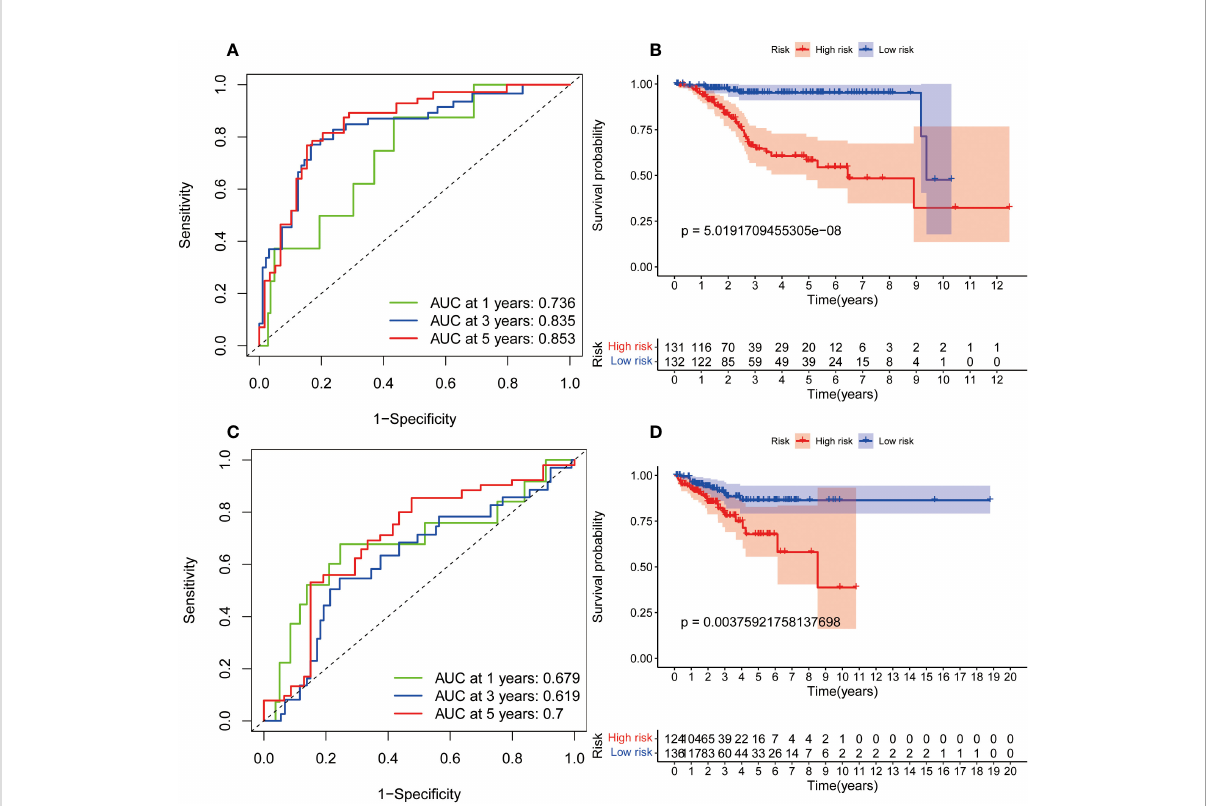
FIGURE 5 The internal veri fi cation of the predictive signature for OS relied on TCGA-UCEC data. (A) The ROC curve at 1-, 3-, and 5-year survival based on internal training cohort. (B) Kaplan-Meier survival curve in internal training cohort. (C) The ROC curve at 1-, 3-, and 5-year survival based on internal validation cohort. (D) Kaplan-Meier survival curve in internal validation cohort. ROC, receiver operating curve; AUC, area under the curve; OS, overall survival; TCGA, The Cancer Genome